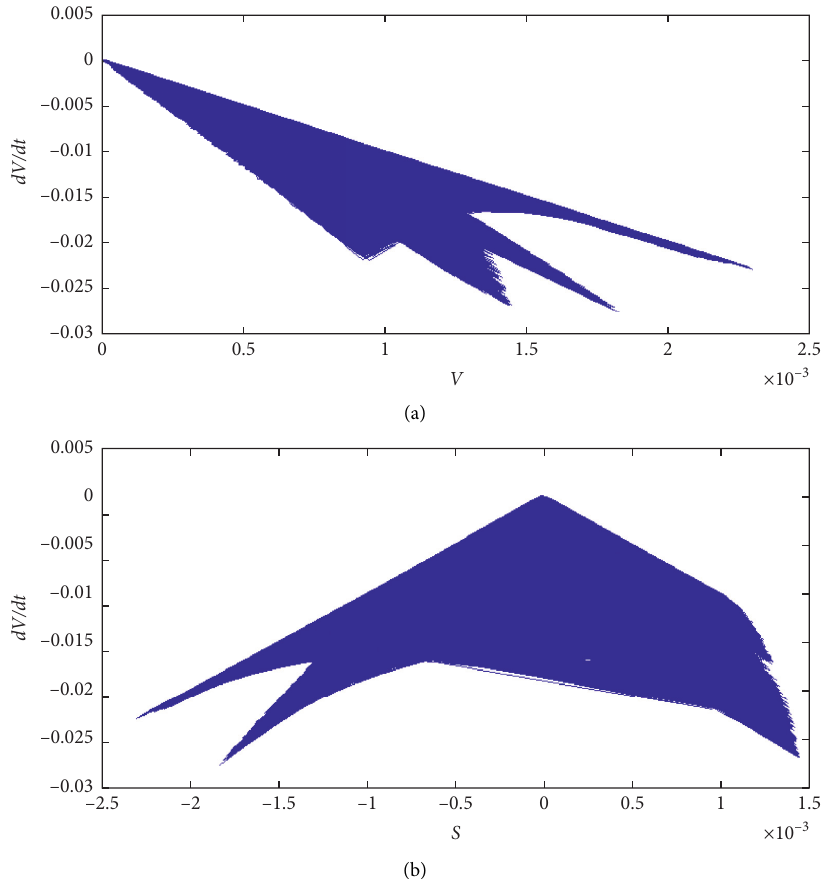
Figure 23: d V /d t versus V and s for the controlled system with σ � 0 . 00005. (a) d V /d t versus V and (b) d V /d t versus s